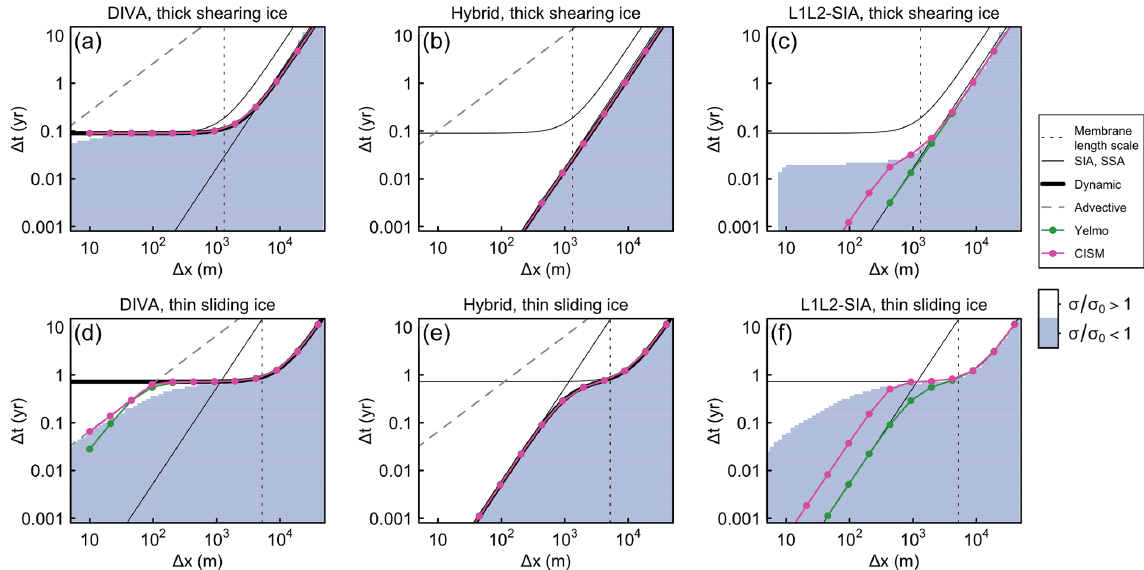
Figure 1. Comparison of the stable time-stepping regime for the DIVA (a, d) , Hybrid (b, e) and L1L2-SIA (c, f) solvers for a 1D slab of ice on a bedrock with constant slope ( α = 10 − 3 ) with thick shearing ice ( a–c , H 0 = 1000m, µ = 1 × 10 5 Payr, β = 1000Payrm − 1 ) and thin sliding ice ( d–f , H 0 = 500m, µ = 4 × 10 5 Payr, β = 30Payrm − 1 ). In all panels, the vertical thin dotted line indicates the membrane stress length scale L m . For the DIVA and Hybrid solvers, the thin dashed grey line shows the advective time-step limit, (cid:49)t adv . For reference, the thin solid black lines show the analytical solutions for an SIA and SSA solver given by Eqs. (31) and (56) with B = β , respectively (the SIA solution is always depicted as a straight line). The thick black lines show the corresponding analytical solution based on Eq. (56) for the DIVA solver and Eq. (69) for the Hybrid solver (not shown for the L1L2-SIA solver). Light blue shading shows where a 1D model following the derivation in the text has a stable solution. The green and magenta lines with solid points show the maximum stable time step as determined using the ice-sheet models Yelmo and CISM, respectively. In several panels, the analytical solution and CISM and Yelmo results